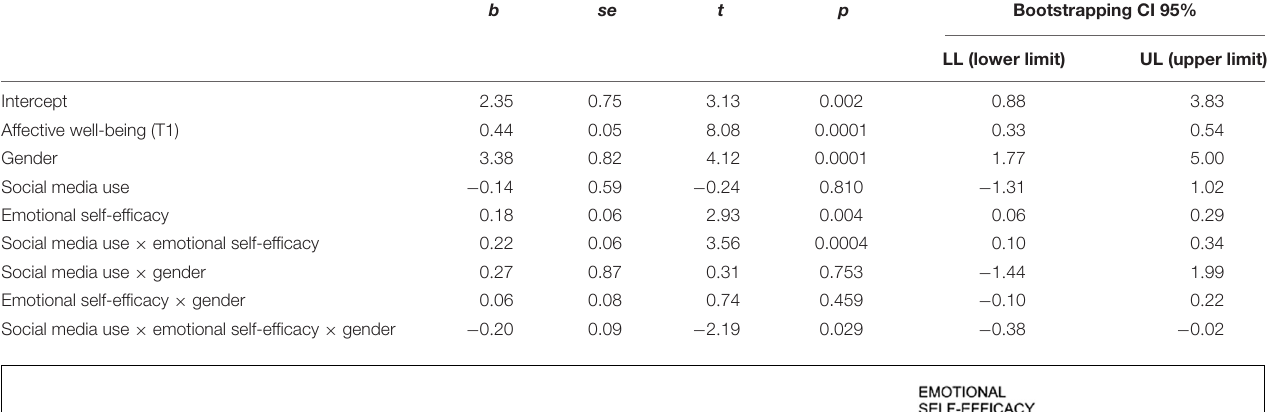
TABLE 4 | Predictors of affective well-being (T2) (regression analysis).